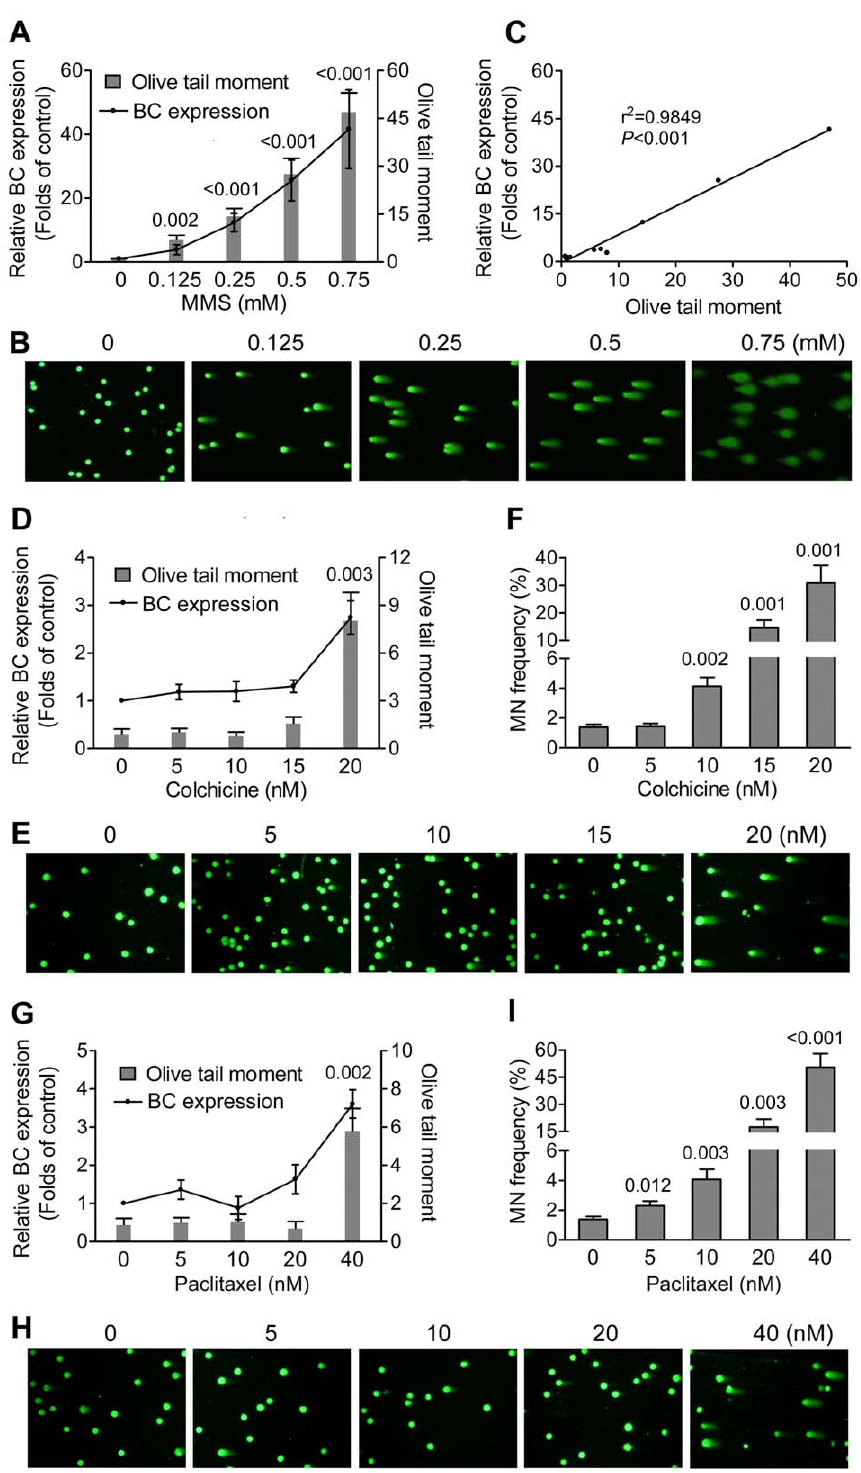
Figure 4. Induced expression level of BC correlated with DNA damage in NIH/3T3 cells. ( A, B, D, E, G and H ) Comparison between expression level of BC and DNA damage in NIH/3T3 cells exposed to MMS (A, B) for 8 h, or to colchicine (D, E) or paclitaxel (G, H) for 24 h. DNA damage was measured by olive tail moment (tail length 6 percentage of DNA in tail) in an alkaline comet assay (representative figures are shown in B, E and H). Data were mean 6 s.d. of three independent experiments. ( C ) Linear regression analysis between expression level of BC and DNA damage, reflected by olive tail moment. Each dot represents the mean of data shown in (A), (D) and (G). ( F and I ) Micronucleus frequency in NIH/3T3 cells exposed to colchicine or paclitaxel for 24 h. Data were mean 6 s.d. of three independent experiments. Values shown on top of bars are P values vs control.